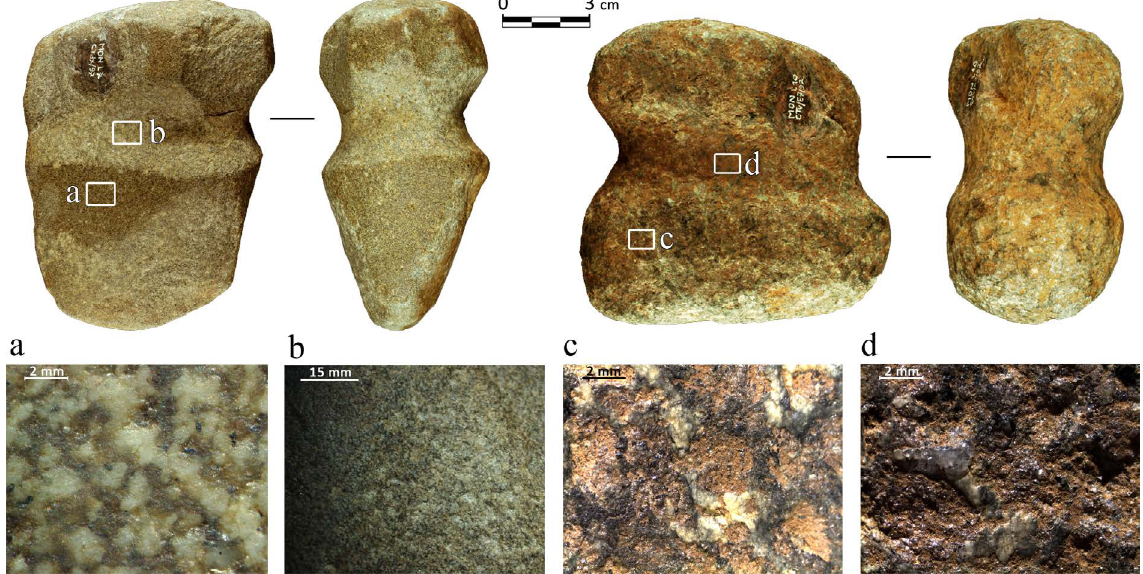
Figure 9. a. Frontal surface of a polished hammer-axe; b. polished groove of a hammer-axe: not completely abraded traces of the previous pecking are still visible; c. detail of the surface of a hammer with pecking pits; d. groove of a hammer with clear traces of pecking (photos of the artefacts by F. Larocca; stereo-microscope photos by F.